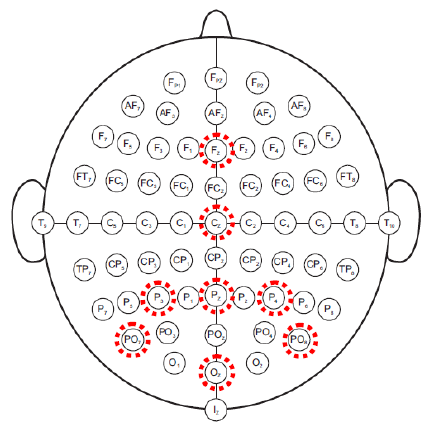
Figure 3. Electrode montage for P300 protocol.